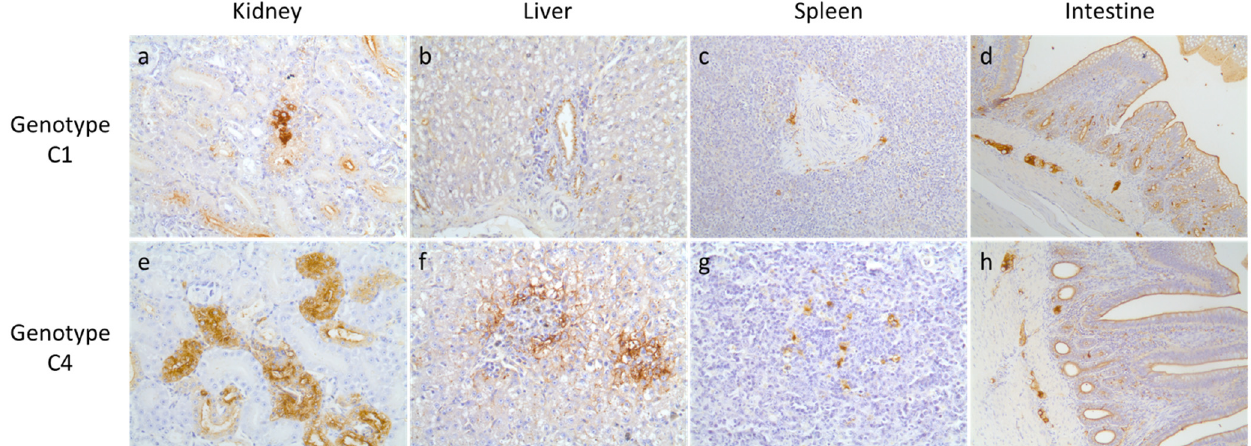
Figure 3. Immunohistochemistry of organs from mandarin ducks. Influenza-specific signals were detected by diaminobenzidine (brown precipitate) in the ( a ) kidney (400×), ( b ) liver (400×), ( c ) spleen (200×), and ( d ) intestine (200×) of mandarin ducks infected with genotype C1 of clade 2.3.4.4 H5N6 HPAIV, and the ( e ) kidney (400×), ( f ) liver (400×), ( g ) spleen (400×), and ( h ) intestine (200×) of mandarin ducks infected with genotype C4 of clade 2.3.4.4 H5N6 HPAIV.